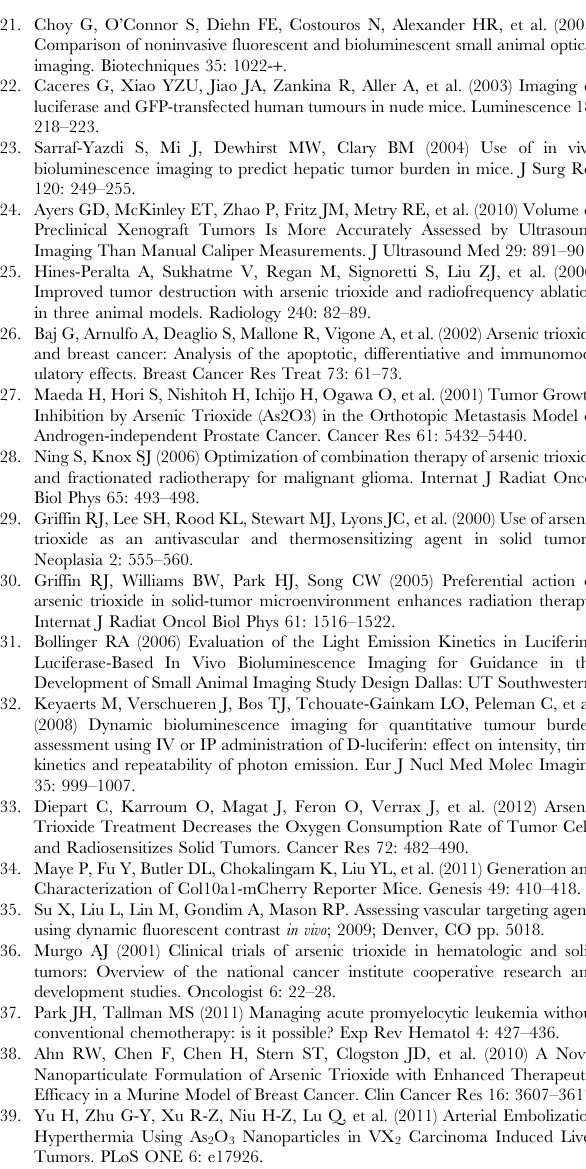
Figure S3 Correlation between B-mode US images and caliper- measured tumor volume: repeat images for a single MCF7-Luc- mCherry tumor and wire mesh analyses below. Graph shows strong correlation between US and caliper-measured tumor volumes (R 2 . 0.8). Figure S4 Vascular disruption assessed by BLI in PC3-luc tumor. Left) Variation in bioluminescent signal intensity from tumor on sequential occasions before and 2 hrs after administra- tion of ATO (8 mg/kg IP). Right) Representative images acquired 10 mins after administration of fresh luciferin on each